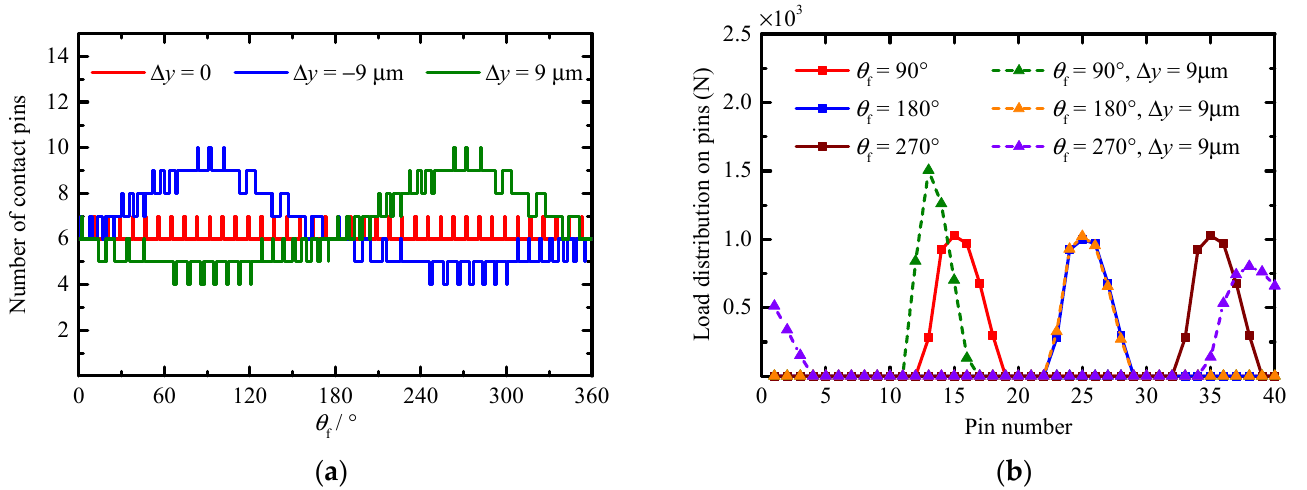
Figure 14. Effect of center distance deviation on ( a ) number of contact pins, and ( b ) load distribution on pins.